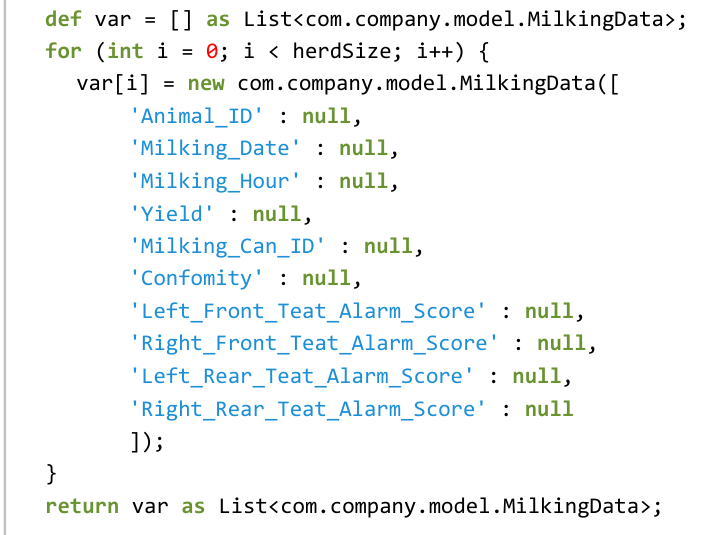
Figure 18. Example of a Groovy script (“initCowsMilkingData”) used to create and initialize a business variable adopted to collect and store a set of cow milking data.